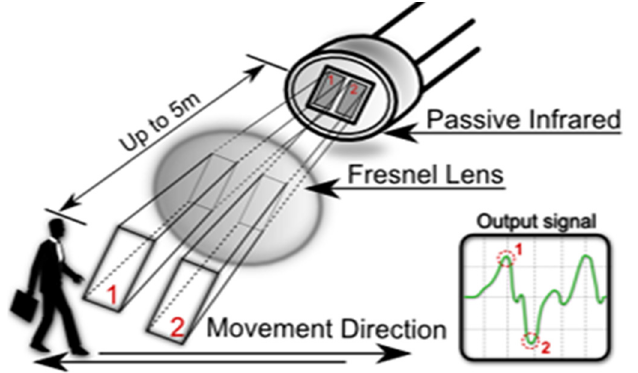
Figure 9. Motion detector operation. (source: http://www.blog.kslemb.com/).